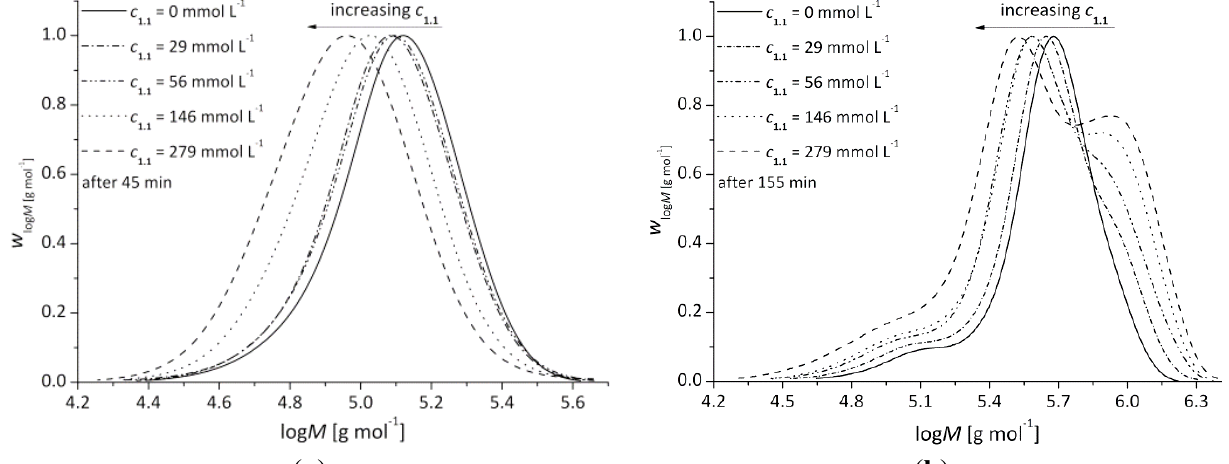
Figure 4. Molar mass distributions (SEC) from different copolymerizations of BA with 1.1 in toluene with 0.6 mmol·L − 1 R 2 and 1.1 mmol·L − 1 AIBN at 60 °C taken after 45 min ( a ), 6 155 min ( b